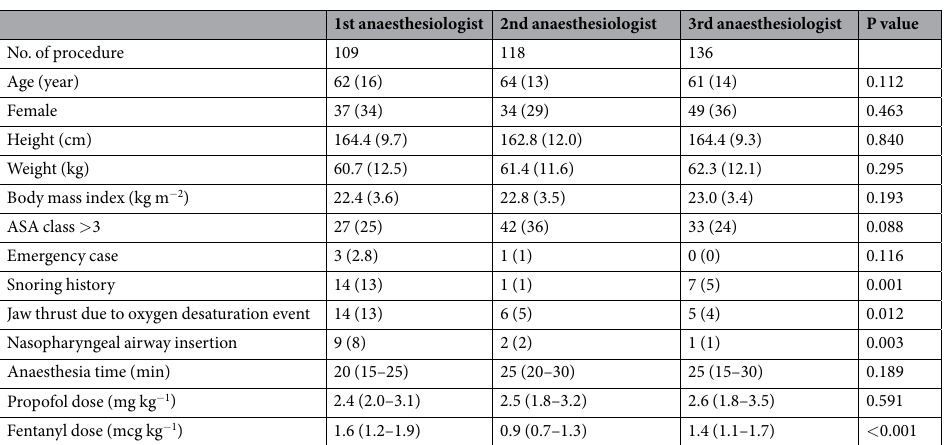
Table 2. Patient characteristics and procedural details per anaesthesiologist in the endoscopic retrograde cholangiopancreatography (ERCP) room. Values are presented as mean (SD), or patient number (%). The P value denotes the probability that the quantity for the different anaesthesiologists belongs to the same